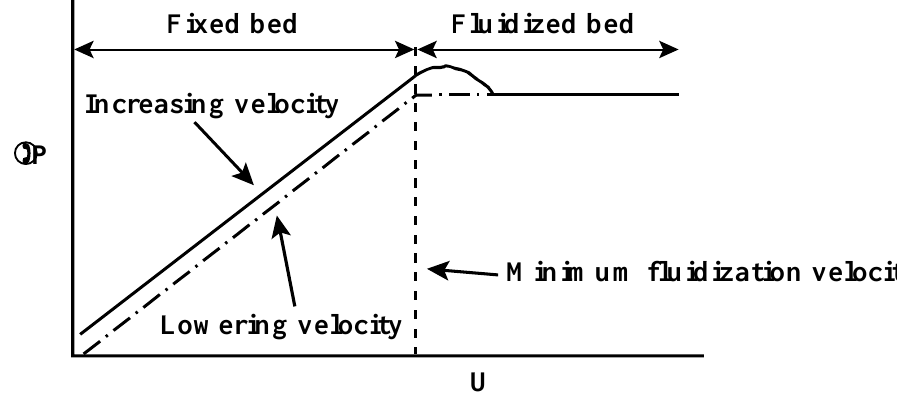
Figure 5. Pressure drop as a function of superficial velocity for an idealized fluidized bed.